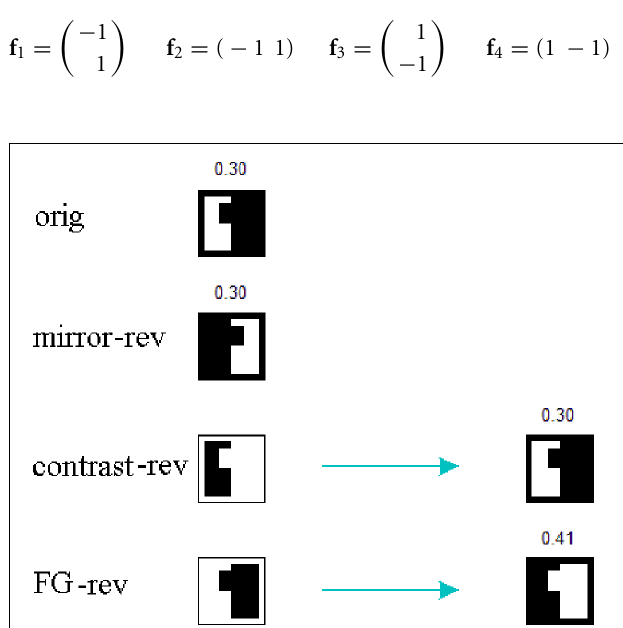
FIGURE 6 | Spiking area ratios for the figural parts. The numbers indicate the ratio between spiking area and total area. For contrast and FG-reversal in F = 1 channel the figure is segregated after “rebound spiking.” Moreover, in the case of FG-reversal the involved area ratio is the largest one.